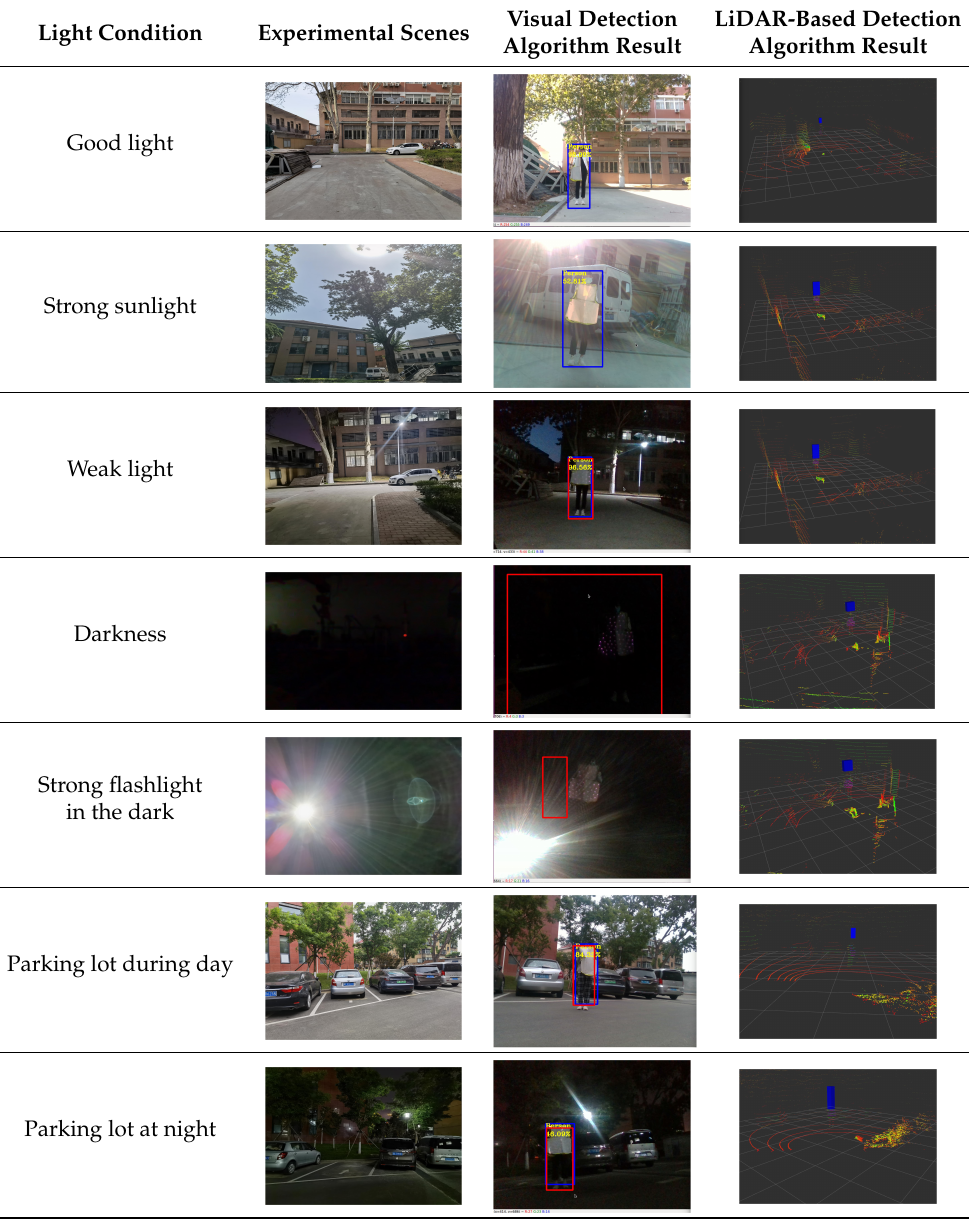
Table 2. The leader detection result under different